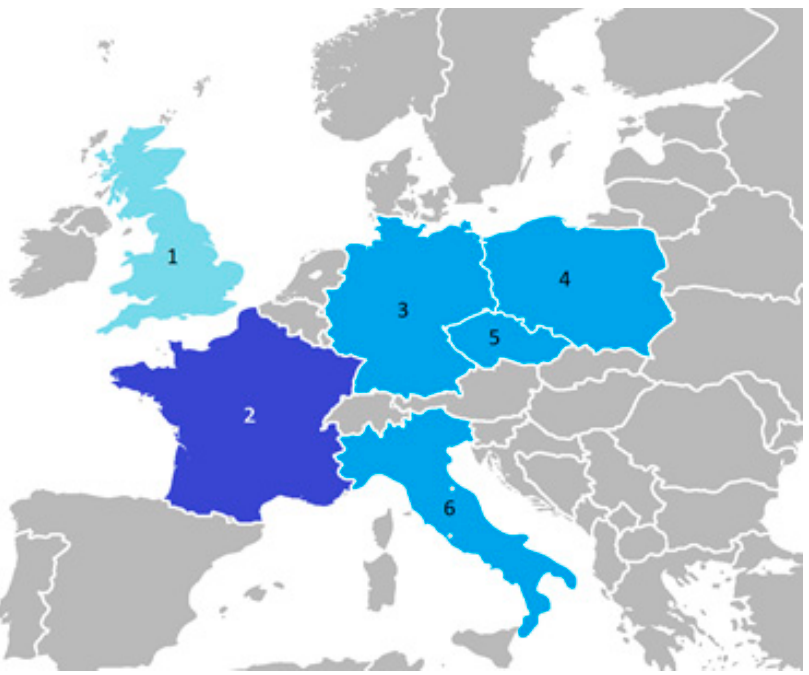
Figure 1. Countries for which original research works on Carabidae beetle fauna on poplar and willow plants were available in searched databases (1—Great Britain, 2—France, 3—Germany, 4—Poland, 5—Czech Republic, 6—Italy; light blue—works used in the study; blue—works used as well not used in the study; dark blue—works not used in the